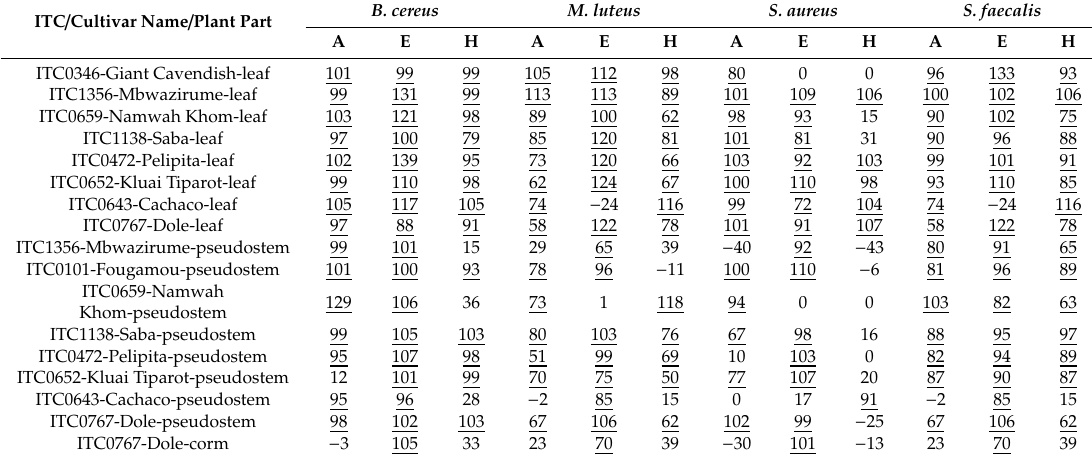
Table 2. Antibacterial activity of selected extracts of banana cultivars against Gram-positive bacteria (relative inhibition in %).